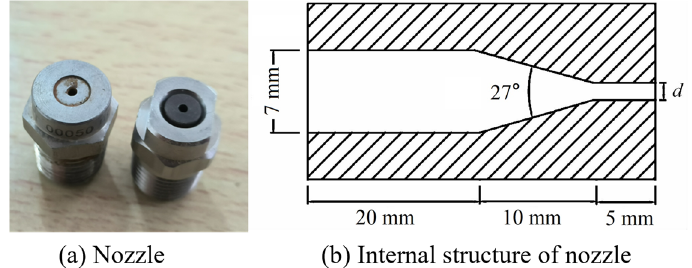
Figure 3. Nozzle size diagram.